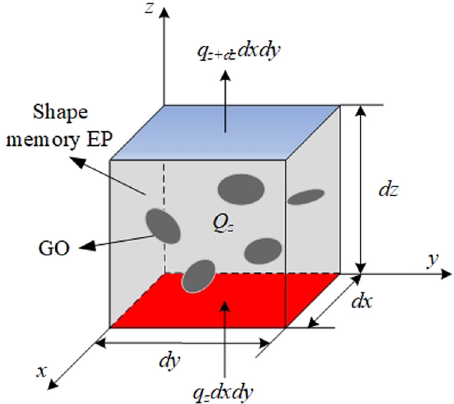
Figure 4: Energy conservation of a